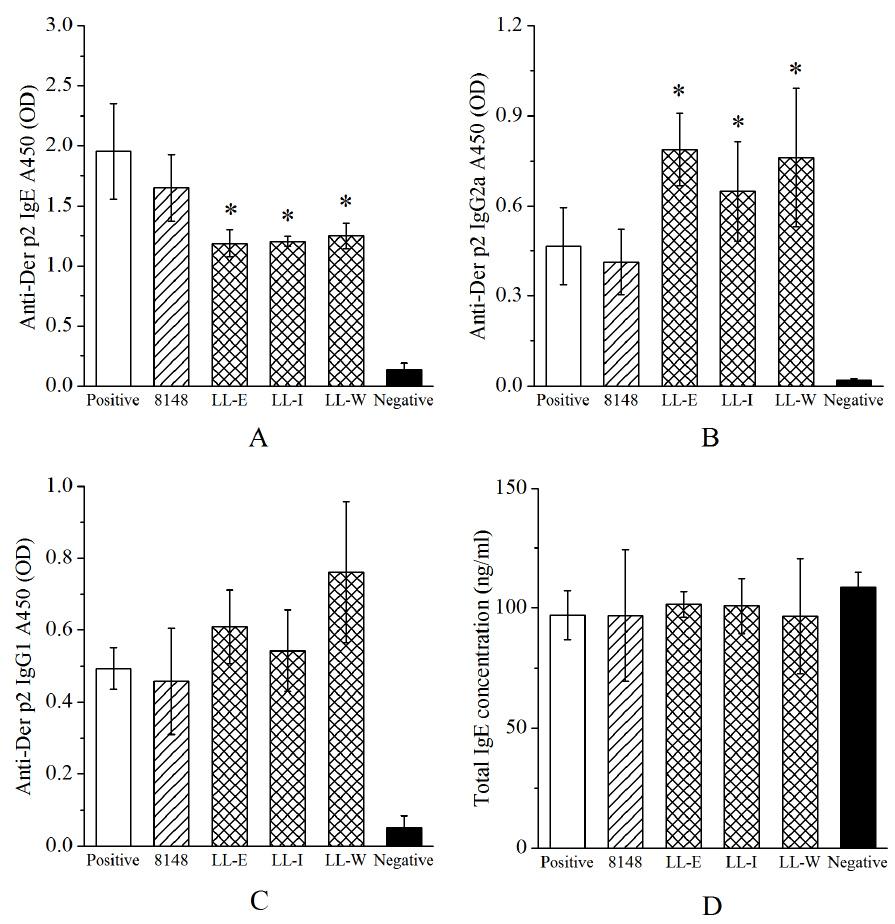
Figure 3. Der p2-specific antibodies and total IgE in serum were detected after inhalation challenge. Der p2-specific IgE (A), IgG2a (B) and IgG1 (C) were measured as optical density (OD) units, and total IgE (D) was reported as ng/ml. Results are means 6 SEM. * P , 0.05 vs the positive group.